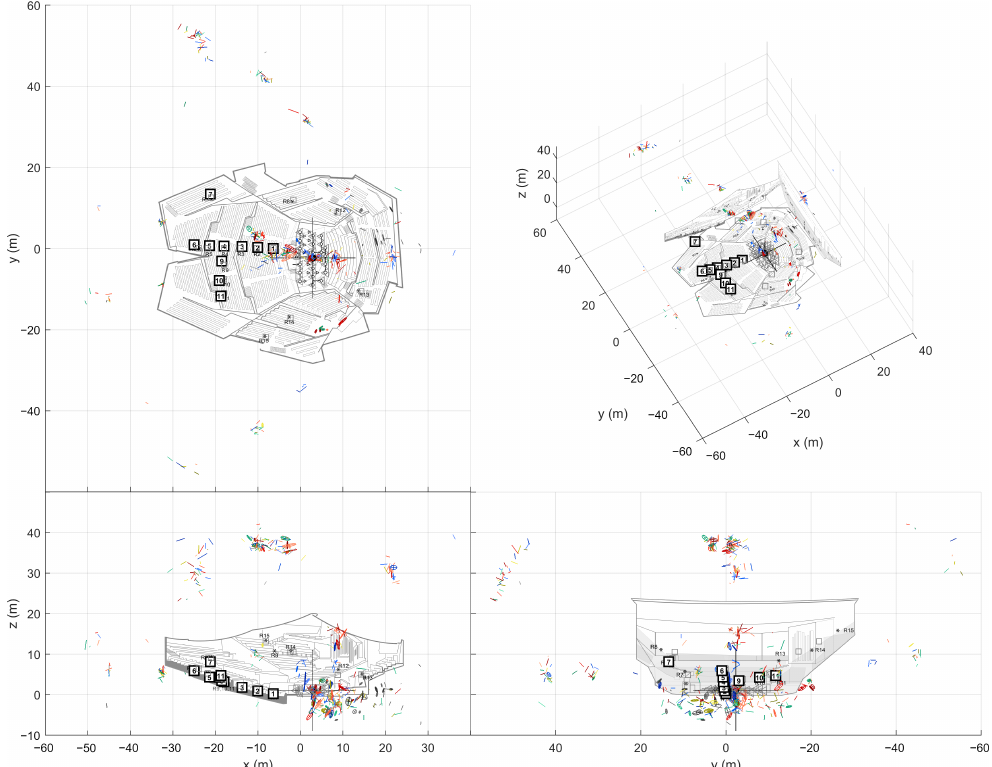
Figure A9. Centered source plot for Berlin